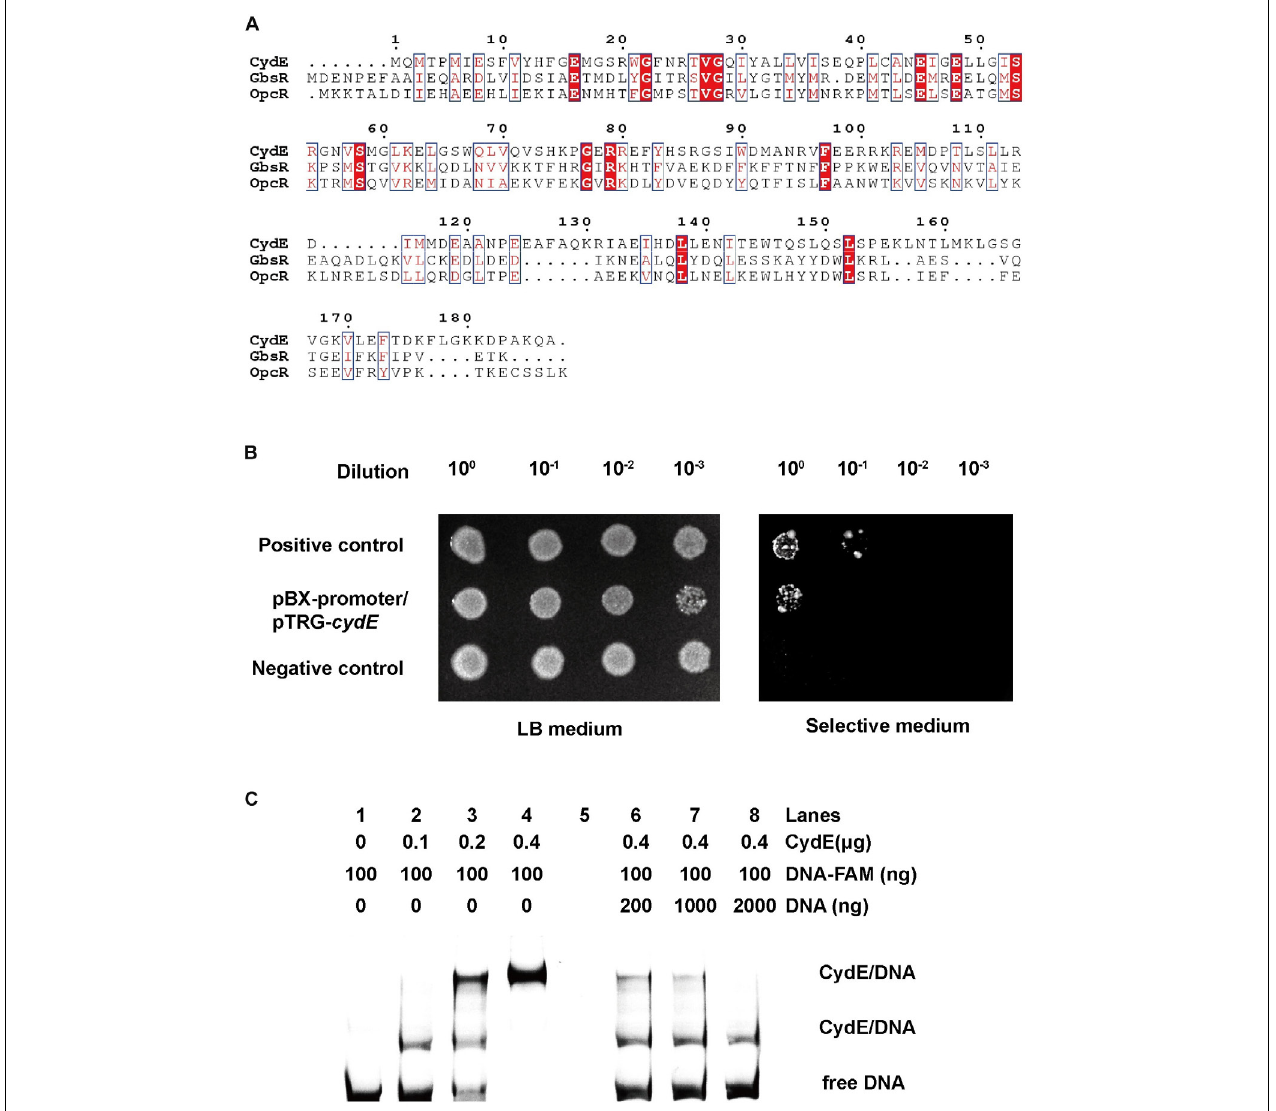
FIGURE 5 | Sequence alignment of CydE and its interaction with the cydE promoter region. (A) Multiple sequence alignment was performed using ClustalW and Espript 3.0. The identical and elevated level of similarity residues are shown in red backgrounds and red boxes, respectively. The amino acid sequences of Bacillus subtilis GbsR (P71015) and Bacillus subtilis _OpcR (O34709) were selected from the UniProt database. (B) Bacterial one-hybrid assay. Co-transformants containing pBX-Mt2031p/pTRG-Rv3133c (Rv3133c protein can integrate with Mt2031p promoter) and empty vector pBXcmT/pTRG (without protein and promoter DNA) were used as positive and negative controls, respectively. Cells of positive and negative controls and the reporter strain containing plasmids pBX-promoter (promoter sequence of cydE ) and pTRG- cydE (coding for CydE protein) were grown to an OD 600 of 1.0, and 2 µ L of each was spotted onto His-selective medium (+3AT, +Str r ) and LB plates (–3AT, –Str r ). (C) EMSA assay. Lanes 1–4, band shifts were enhanced by increased CydE. Lanes 6–8, FAM-labeled DNA was competed by unlabeled DNA. The result showed two migration bands. It indicated that there are two binding sites for the CydE in the cydE promoter